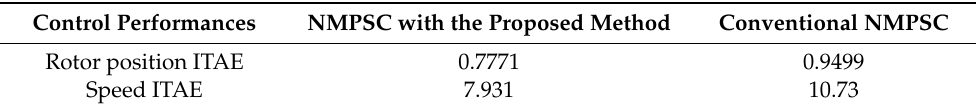
Table 2. Performance comparison within 1.5